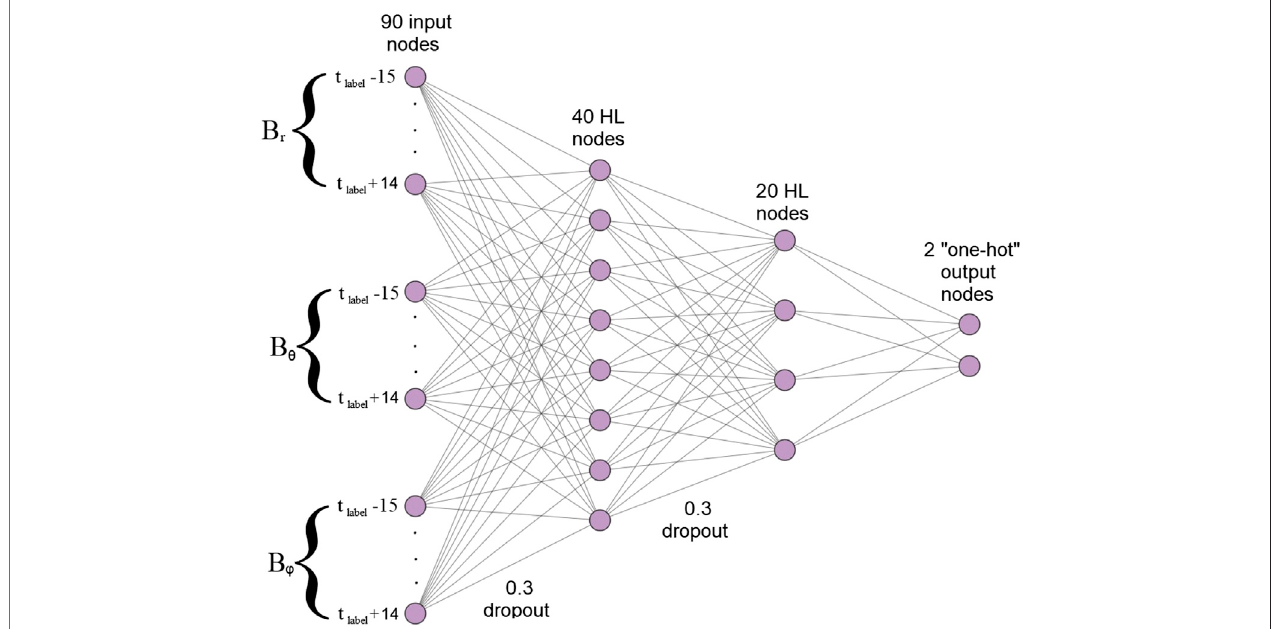
FIGURE 5 | NN architecture used to train to identify reconnection signatures in Cassini magnetometer data. This structure shows 90 input nodes composed of three 30 min time windows centered on the label time ( t label ), in the three KRTP magnetic fi eld components ( B r , B θ , and B ϕ ). These nodes are then fed into a 40 node hidden layer (HL) with a 0.3 dropout, which feeds into a 20 node HL with a 0.3 dropout. This fi nal HL is then categorized using a 2 node, one-hot classi fi cation system. During training, every epoch, the weights and biases interconnecting each layer are varied to under a gradient descent to optimize the accuracy of classi fi cations.